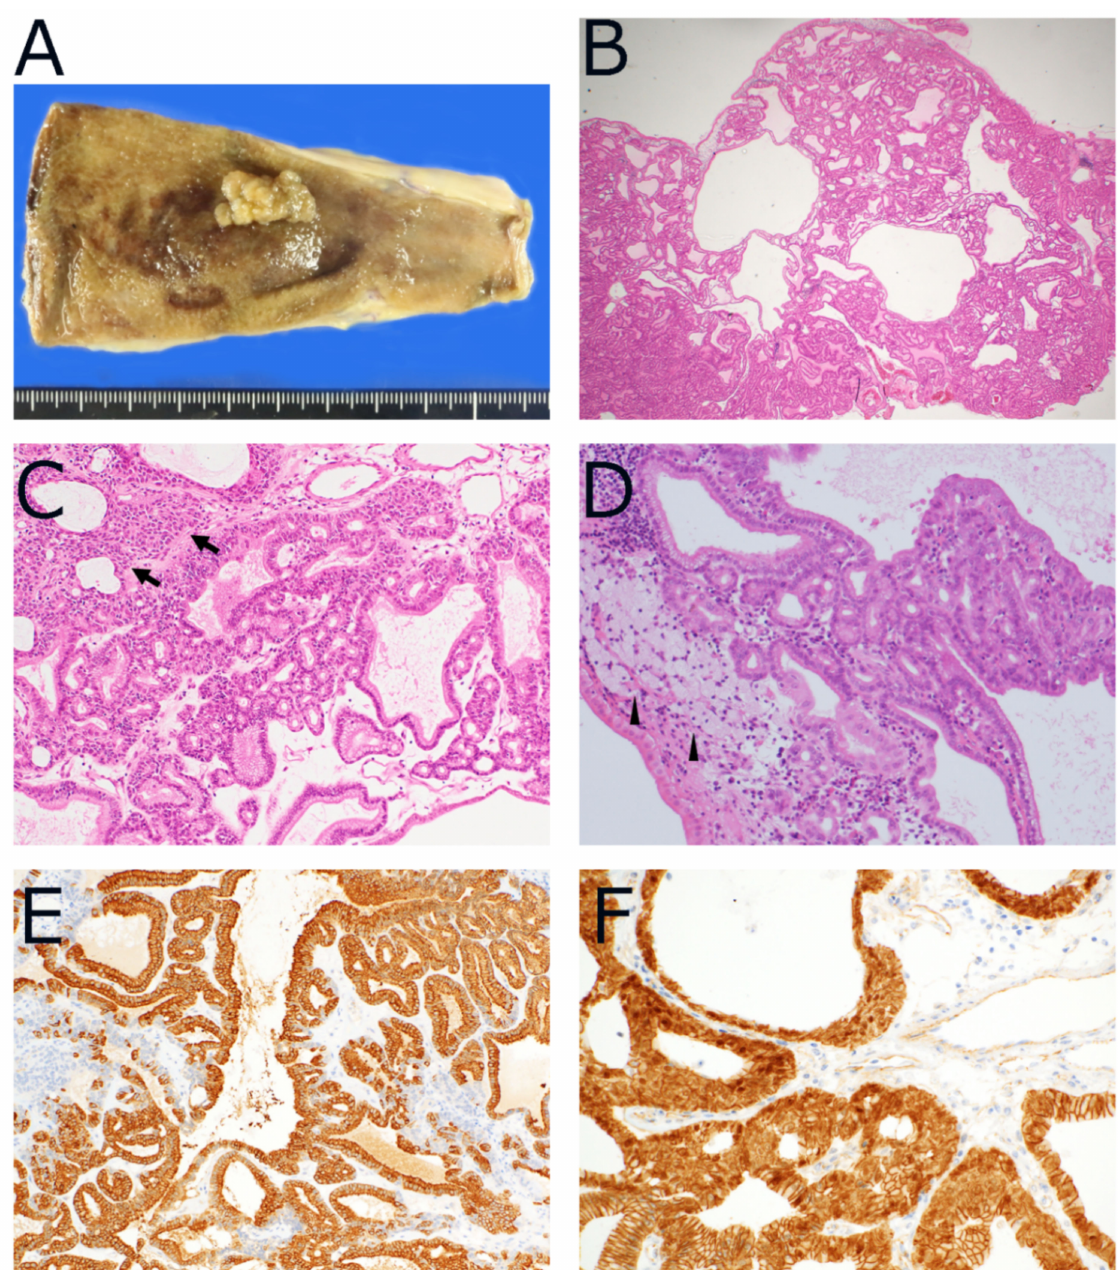
Figure 1. Pathology of pyloric gland adenoma (PGA). ( A ) Sessile-shaped polyp is seen at body of gallbladder. ( B ) Tumor is composed of multiple tubules, some cystically dilated. ( C ) Tumor is composed of cells with intracytoplasmic mucin. Squamoid morules (arrows) are sometimes seen. ( D ) Aggregate of foamy macrophages is seen inside tumor (arrowheads). ( E ) Tumor cells are diffusely positive for MUC6. ( F ) Nuclear expression of β -catenin is often seen. ( B – D ) Hematoxylin and eosin, ( E ) immunohistochemistry for MUC6, ( F ) immunohistochemistry for β